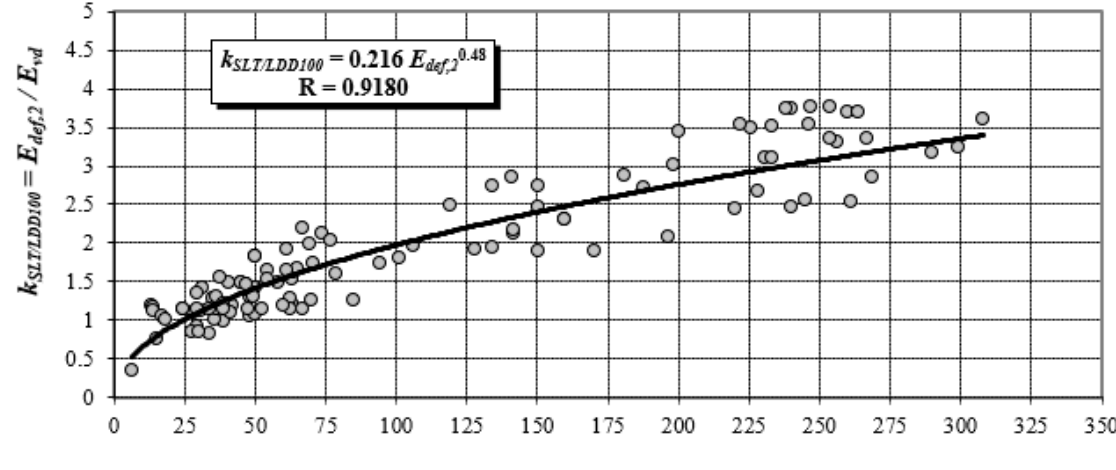
Figure 8. Power correlation dependency of k SLT/LDD100 on E def, 2 .